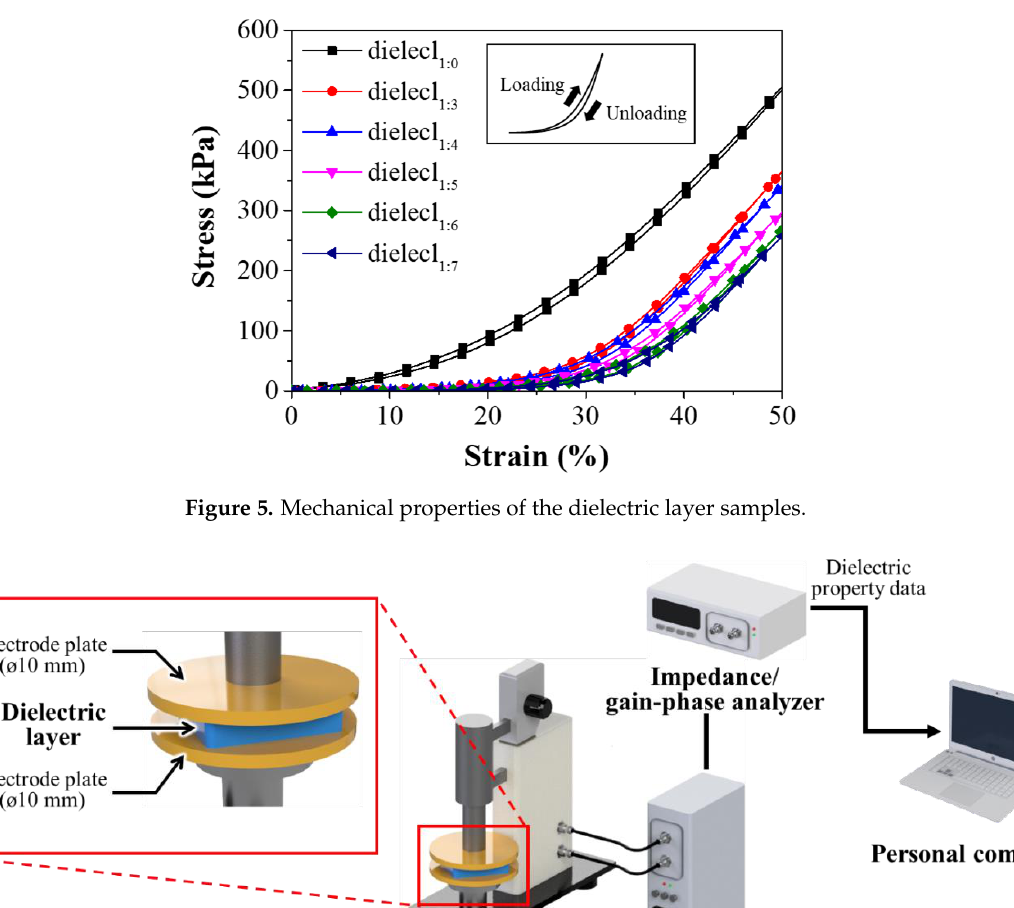
Figure 5. Mechanical properties of the dielectric layer samples.